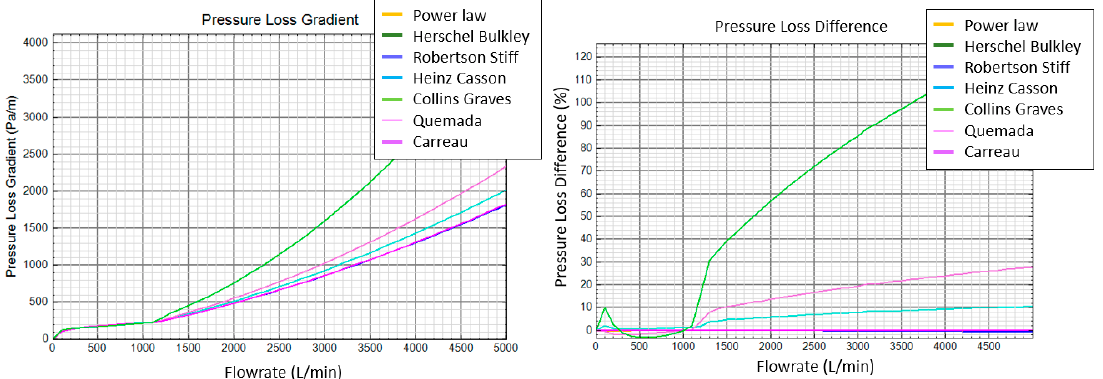
Figure 4. Estimated pressure losses while circulating a KCl/polymer fluid (1250 kg/m 3 at 80 °C) in a 5 in pipe for flowrates ranging between 0 and 5000 L/min.